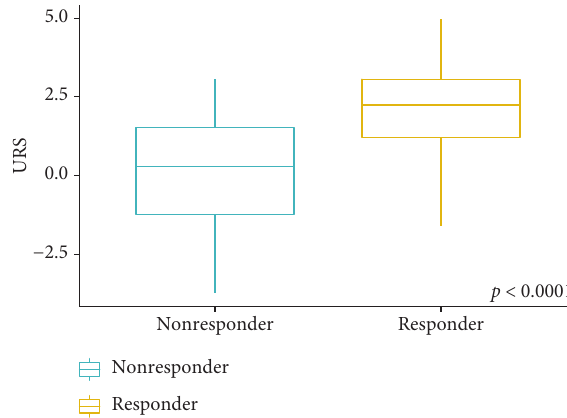
Figure 2: Boxplots of the ursodeoxycholic acid response score in Slovak and Croatian